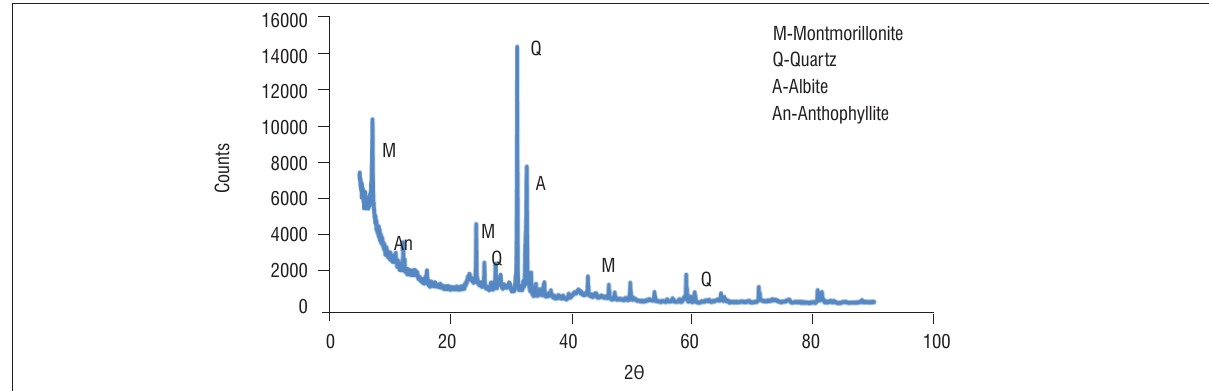
Figure 1: X-ray diffraction spectrum of the smectite-rich clay